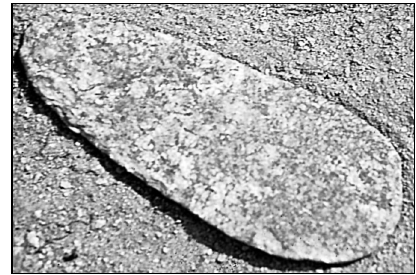
Figure 3 A deliberately buried Pre- ceramic ovate, multipurpose stone tool used for cutting and digging, c. 600 BC ( c. 20cm in length).